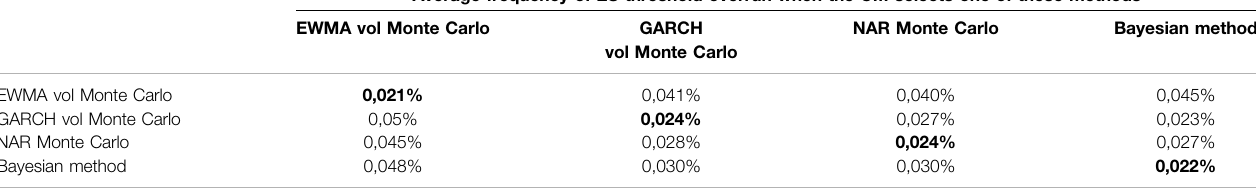
TABLE 6 | Comparative average of overruns below the ES threshold.